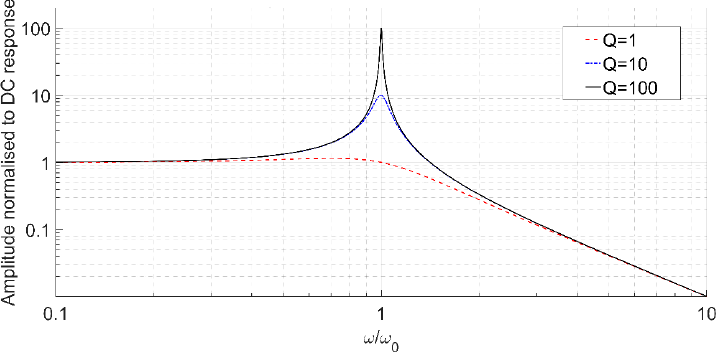
Figure 2. Time and frequency response of resonant systems.